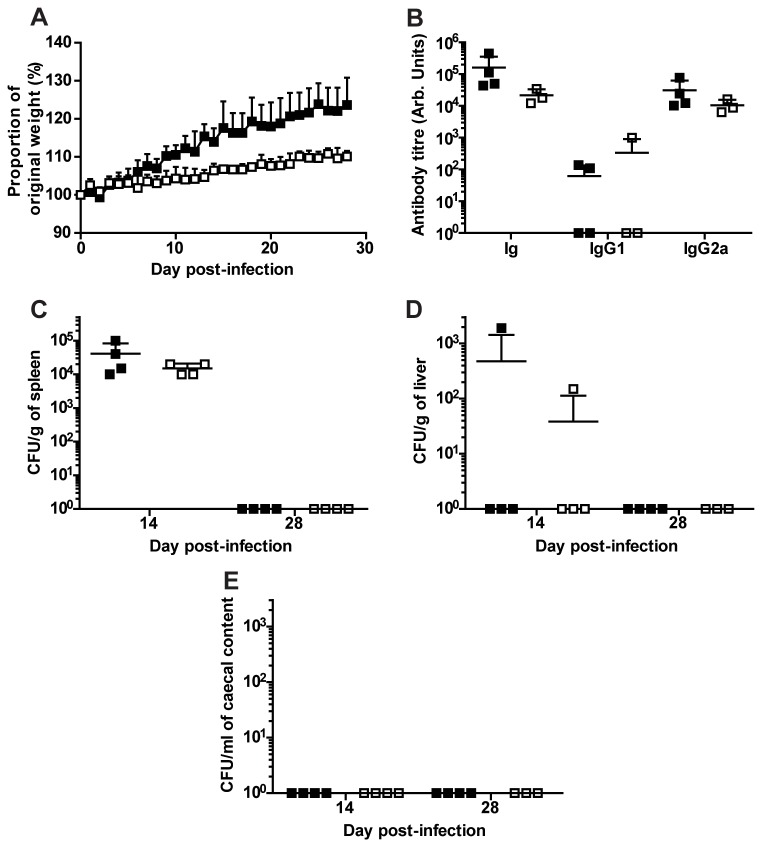

Salmonella Typhimurium challenge of wild type and Ifitm3-/- mice.Mice were intravenously injected with S. Typhimurium and observed for weight loss for 28 days pi (A). Mice were killed on day 28 pi to assess neutralising antibody titre against S. Typhimurium (B). Bacterial contents from spleen (C), liver (D) and caecal contents (E) were titred on days 14 and 28 pi to assess the bacterial colonisation. ■: wild type, □: Ifitm3-/-. Results show means ± S.D. (n > 3).